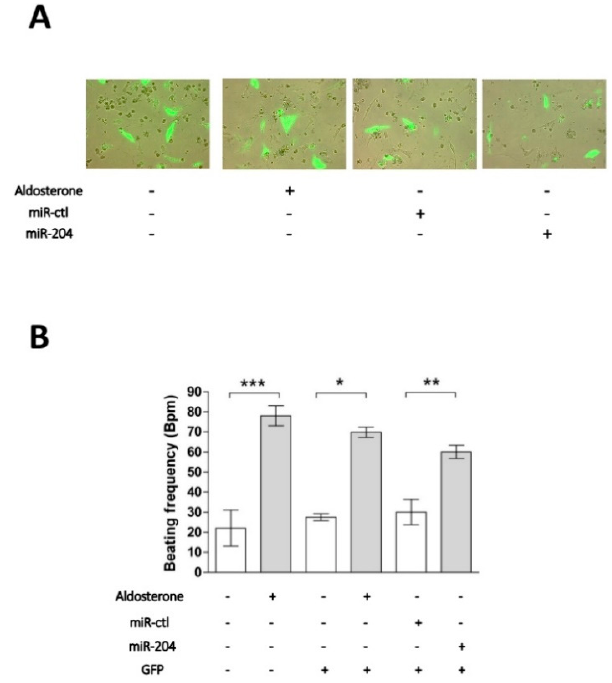
Figure 2. MiR-204 mimics the chronotropic action of aldosterone in cardiomyocytes. ( A ) Neonate rat ventricular cardiomyocytes in culture were electroporated and immediately transfected with a plasmid coding for GFP either alone or in the presence of miR-204 or a control microRNA (miR-ctl). Images show representative cell fluorescence observed 24 h after cell transfection under various experimental conditions. ( B ) The cardiomyocyte beating frequency was determined by counting individual cell contractions under the microscope 24 h after cell transfection and/or incubation under several experimental conditions (indicated below the graph by the presence of a + sign). When cells were co-transfected with the GFP plasmid, only the beating frequency of fluorescent cells was